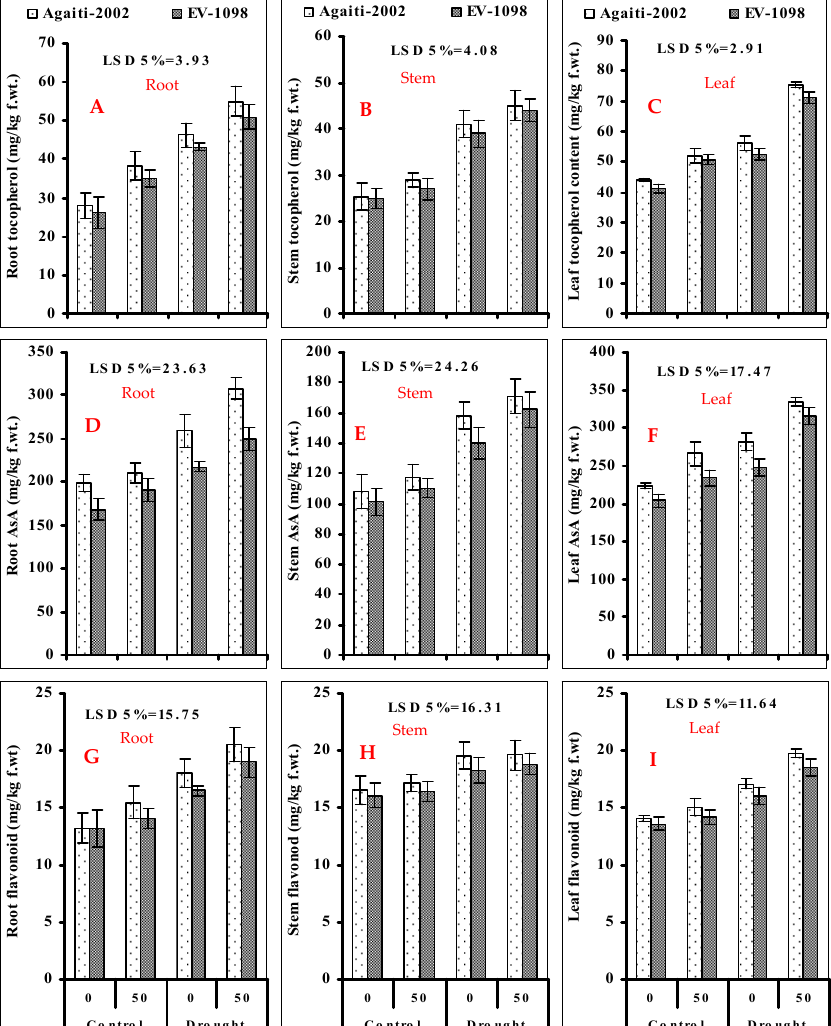
Figure 1. Root, stem, and leaf total-Toc ( A – C ), AsA ( D – F ), and total flavonoids ( G – I ) of maize plants foliar-applied with α -Toc when grown under water deficit conditions (mean ± SE; n = 4); AsA = ascorbic acid; 0 and 50 = mmol solution of α -Tocopherol for foliar spray. AsA and flavonoid contents in di ff erent studied plant parts also increased significantly in both genotypes under water deficit conditions, and this improvement in AsA and flavonoid accumulation was more in root and leaf in cv. Agaiti-2002 in comparison to cv. EV-1098 (Figure 1; Table